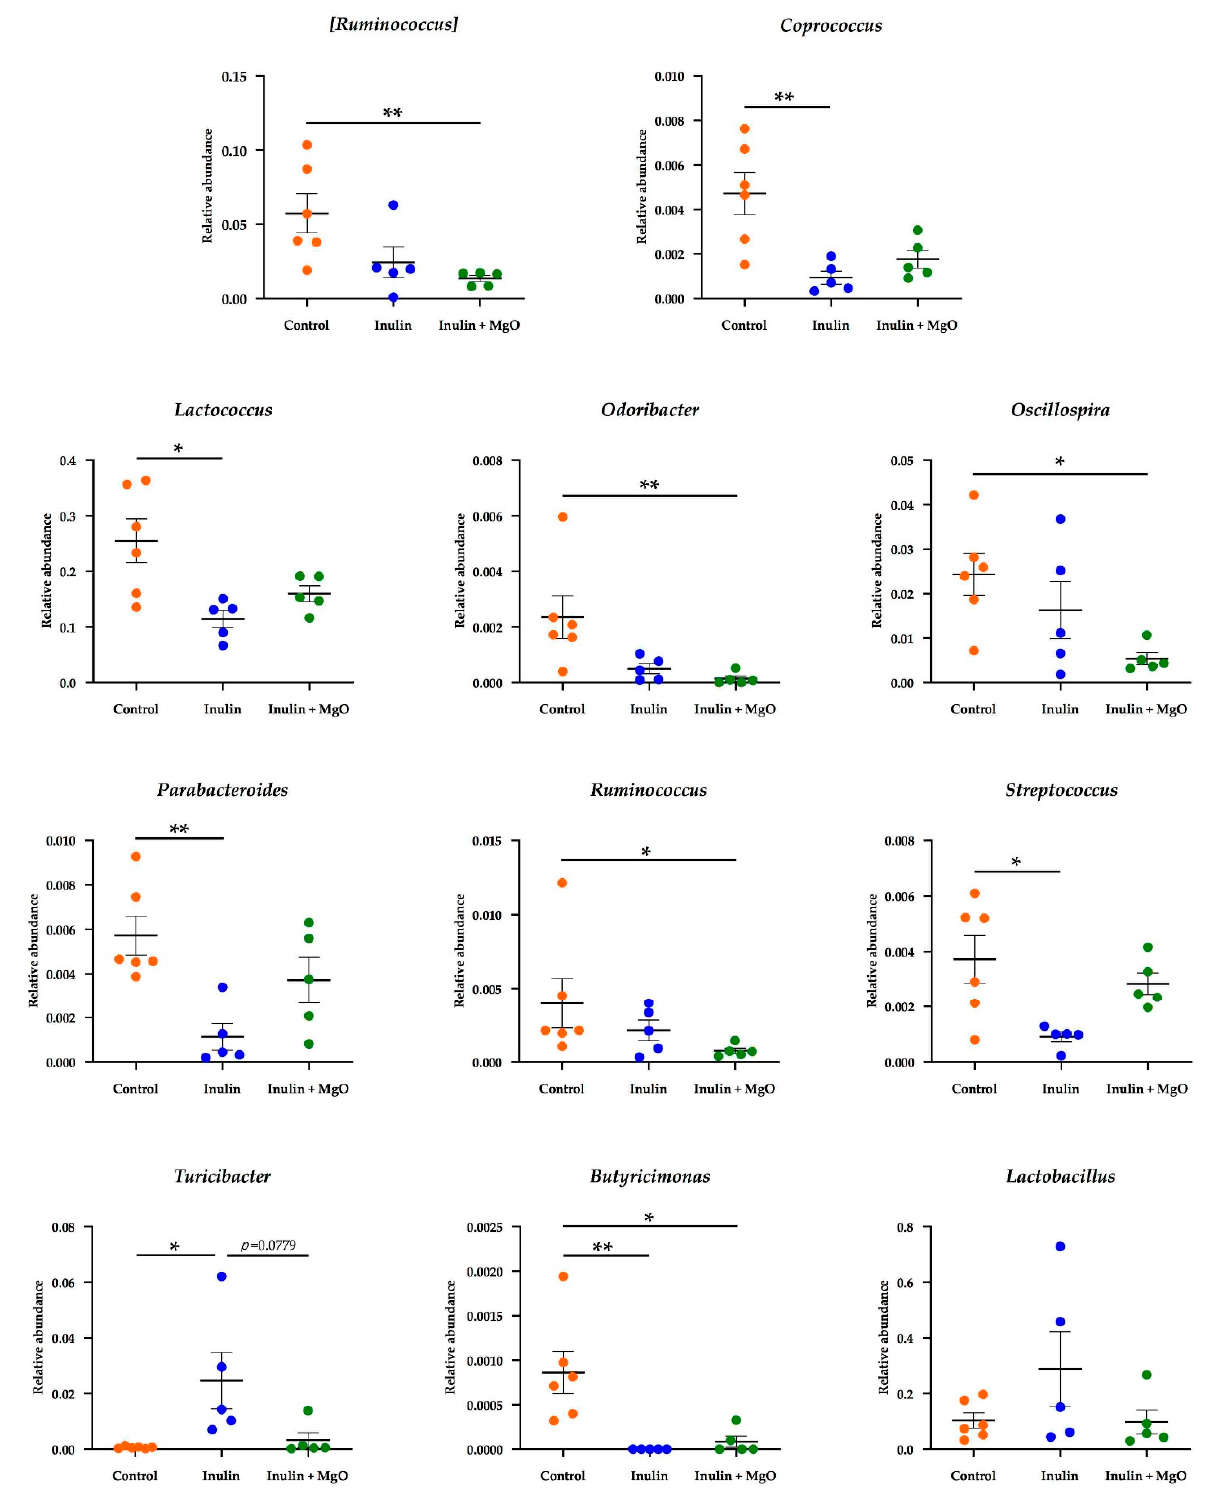
Figure 6. The combined inulin and MgO effects on intestinal bacteria at the genus level in mice on a HFD. Inulin was mixed with the HFD at a ratio of 2.5% in the inulin group and the MgO combination group. Magnesium oxide was given in the diet at a ratio of 0.25%. All data are expressed as mean ± standard error (Each group n = 5–6). * p < 0.05, ** p < 0.01. Data were evaluated using the Kruskal-Wallis test with Dunn’s post hoc test. MgO: magnesium oxide. HFD: high-fat diet.